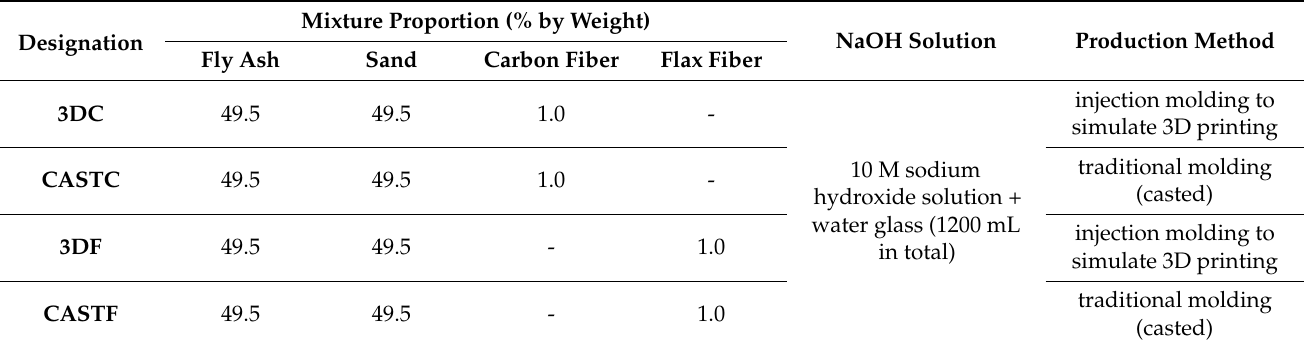
Table 6. Designation of manufactured